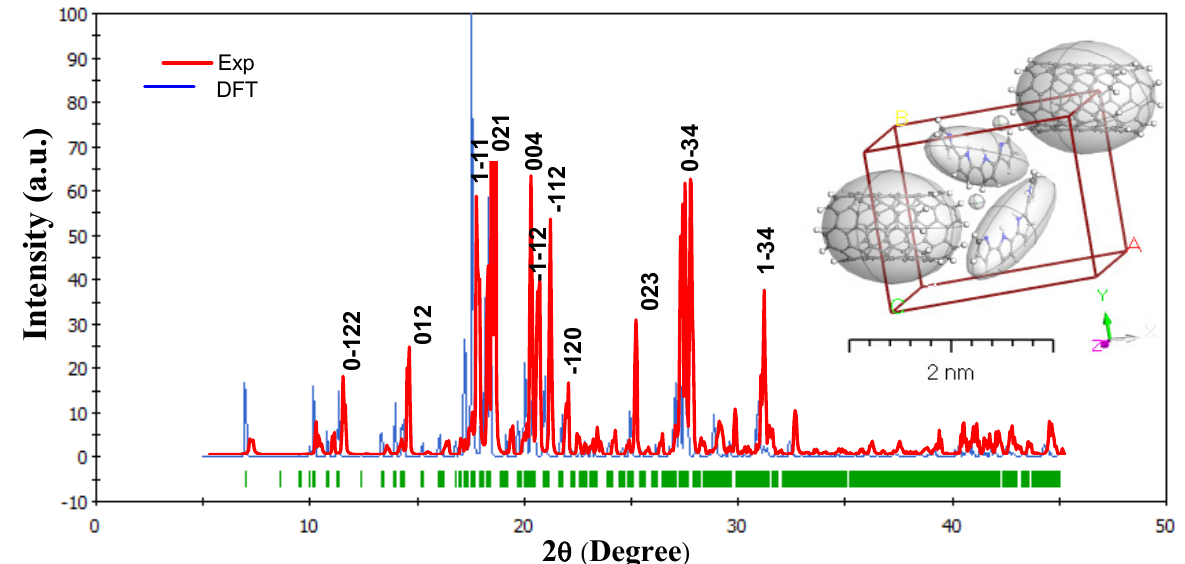
Figure 2. Combined between the experimental and simulated PPy/MWCNTs composites’ X-ray diffraction (XRD) patterns, inset Figure is lattice type: 3D Triclinic by using Polymorph computation method. Table 2. The computation data resulted from the application Refine Version 3.0 Software Program (Kurt Barthelme’s and Bob Downs) for PPy/MWCNTs composites.